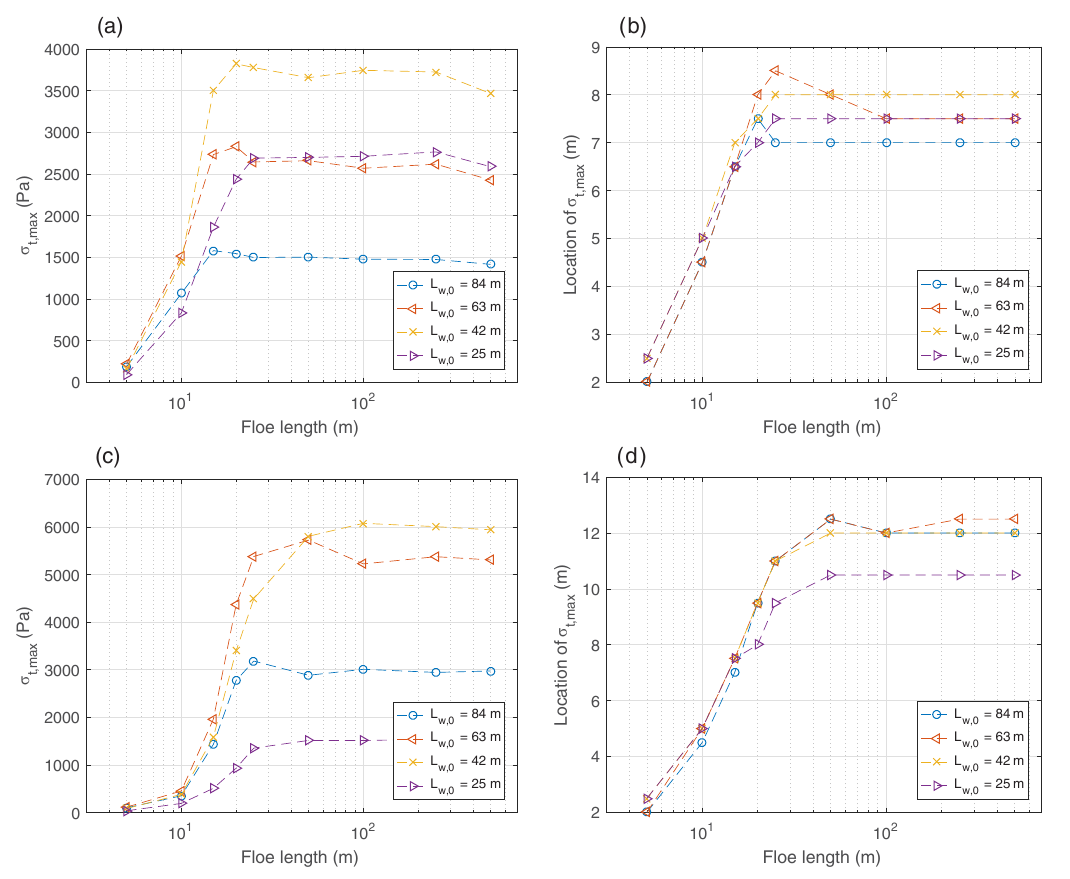
Figure 6. Simulated maximum tensile stress σ t , max (a, c) and location (distance from the up-wave ice edge) at which it occurs (b, d) for different floe length L o and open-water wavelength L w , 0 values; ice thickness is h i = 0 . 5m (a, b) and h i = 1 . 0m (c, d) . Note that the x axis is logarithmic.